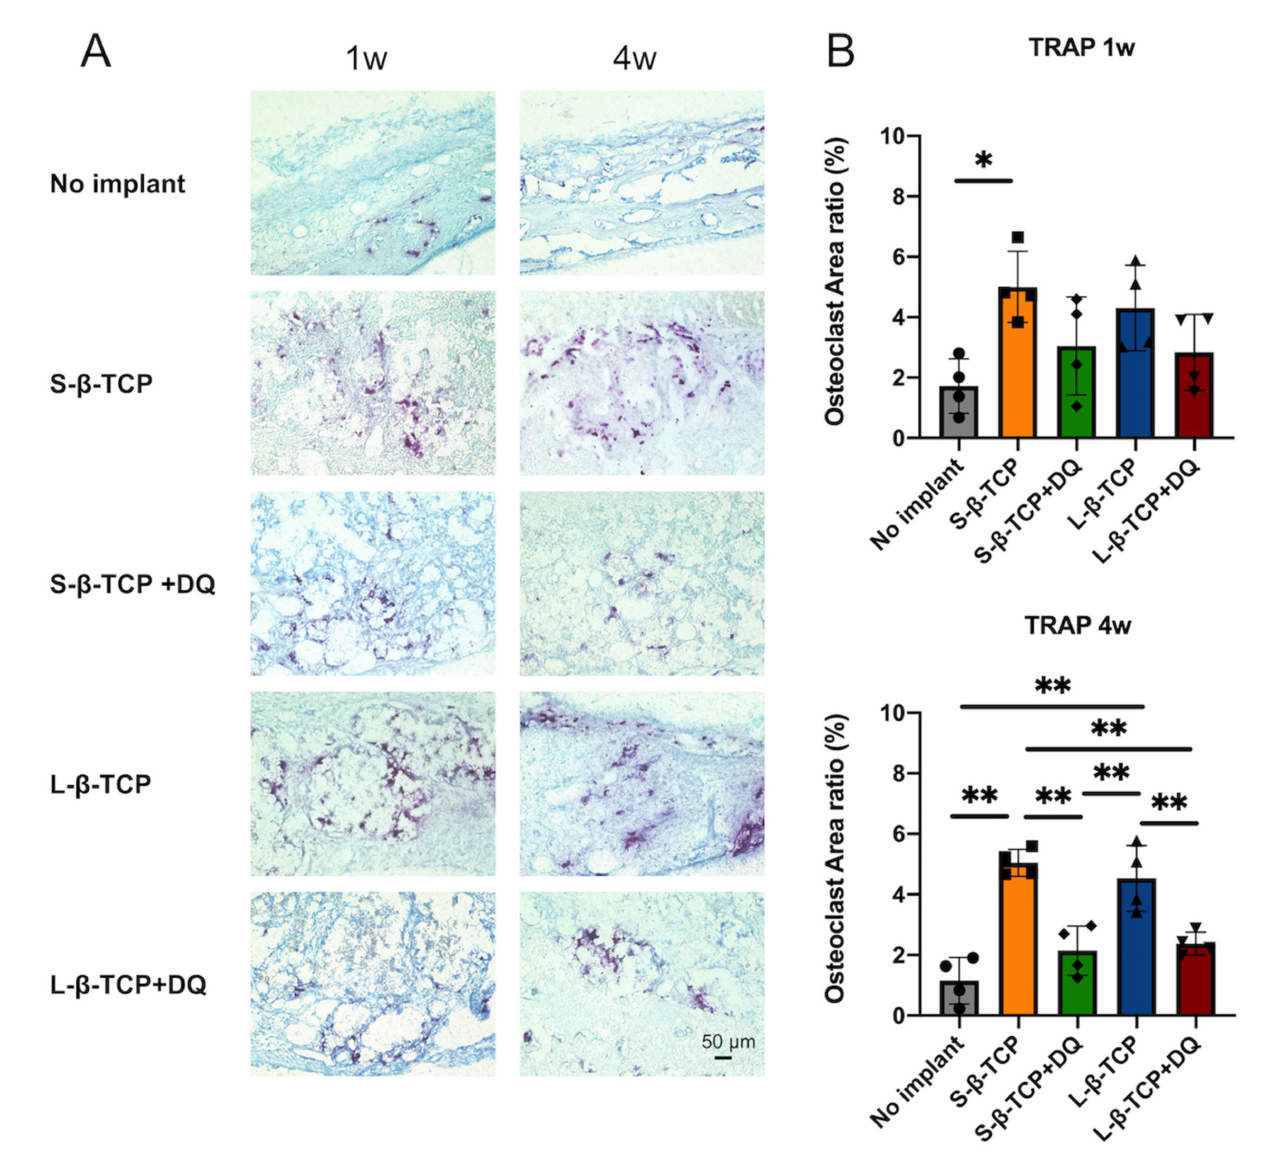
Figure 11. Detection of osteoclasts in bone defects. ( A ) Tartrate-resistant acid phosphatase (TRAP) staining images of the bone defect (scale bar = 50 µ m); ( B ) the histomorphometric analysis of osteoclast using samples of TRAP staining. Mean with SD ( n = 4). * p < 0.05, ** p < 0.01: One-way ANOVA analysis with Tukey–Kramer method as post hoc